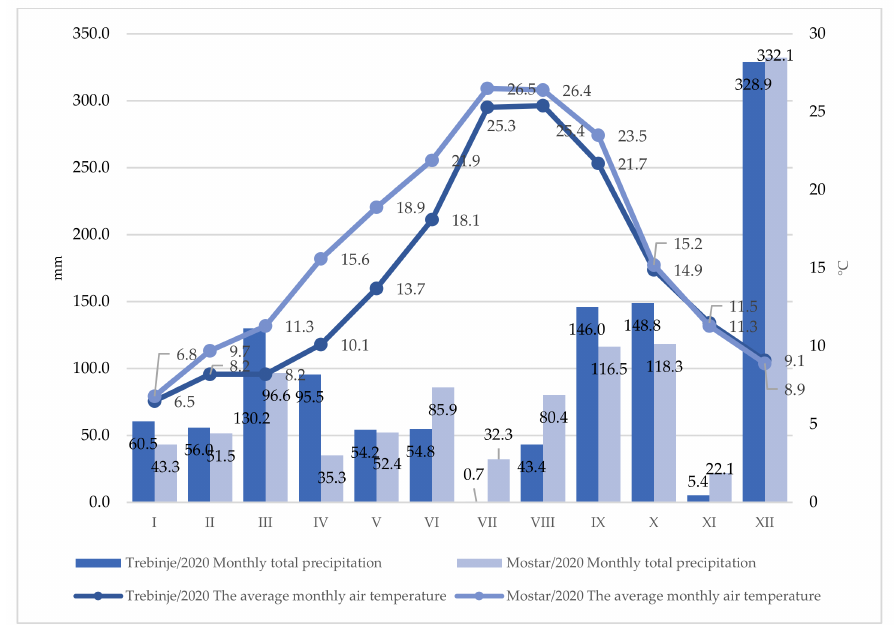
Figure 1. Climatic conditions (total rainfall and average air temperature) at Trebinje and Mostar localities during